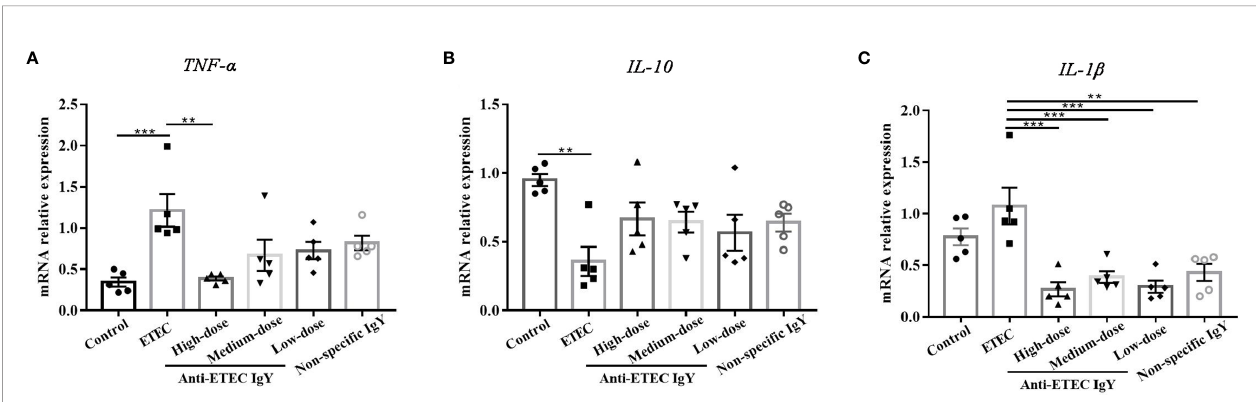
FIGURE 6 | Proin fl ammatory and anti-in fl ammatory cytokines mRNA expression in jejunum of control (neither IgY nor ETEC infection) mice, ETEC-infected mice, ETEC-infected mice treated with high-, medium- or low-doses anti-ETEC IgY or ETEC-infected mice treated with non-speci fi c IgY. (A) TNF- a mRNA expression; (B) IL-10 mRNA expression; (C) IL-1 b mRNA expression. Values are expressed as least squares mean ± SEM, n =5. ** P < 0.01, *** P <